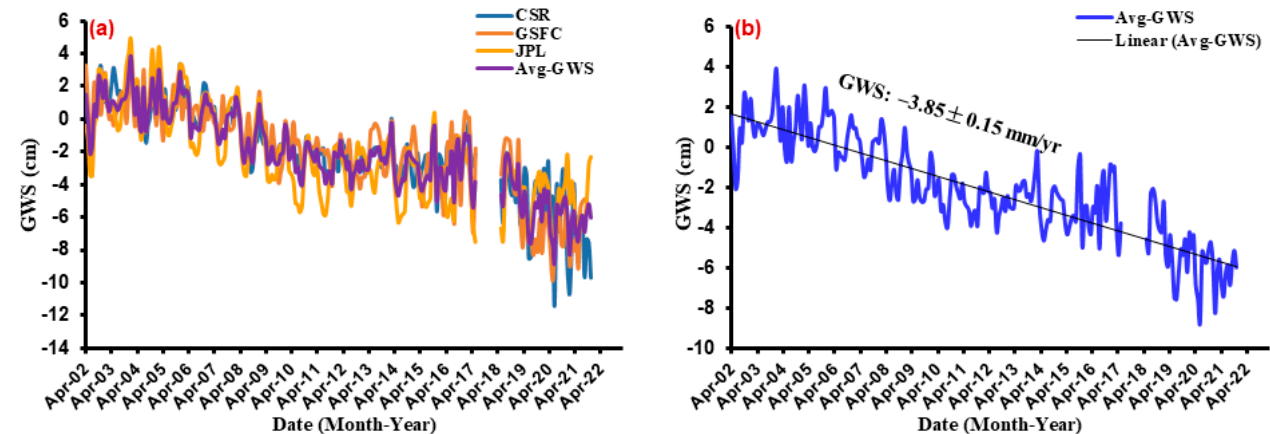
Figure 10. Monthly time series for the GWS ( a ) and their mean ∆ GWS ( b ) for the study area.